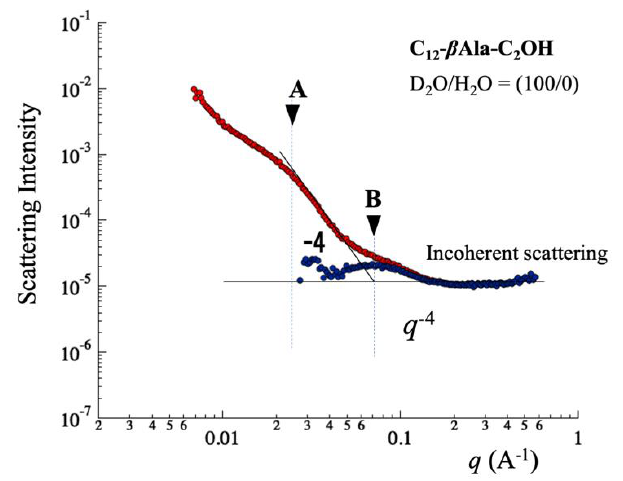
Figure 17. Examination of SANS observed at 600–1800 s; the asymptotic q- behavior q − 4 at q = 0.03~0.04 A − 1 (solid line) was subtracted, so a broad scattering maximum appeared at the same q value for the micelle in the foam (B in Figure 16). Solid lines are guides for the eye.